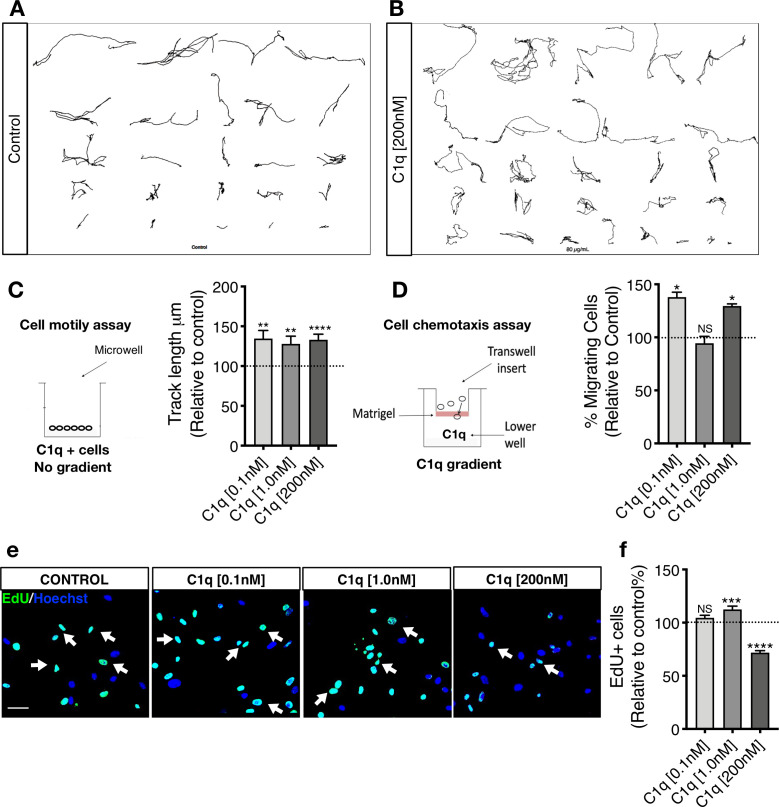
C1q induces NSC motility and chemotaxis in vitro.(A-C) Exposure to C1q in the absence of a gradient increases hNSC motility independent of concentration. Manual tracking of 20 randomly selected cells per biological replicate in live-cell imaging assay reveals that C1q increases hNSC motility as measured by track length, independent of C1q concentration. Representative image of 20 manual tracks from cells in (A) control and (B) C1q [200 nM] condition. (C) Data normalized to untreated control (dashed line). Statistical analysis using one-sample t-test (*p≤0.05, **p≤0.01; N = 3 biological replicates) for comparison with control. ANOVA analysis for comparison between groups, p=0.8682. (D) Exposure to C1q in transwell assay for analysis of chemotaxis reveals that C1q induces hNSC migration in a concentration-dependent manner, with maximal effects at 0.1 nM and 200 nM. Data normalized to untreated control (dashed line). Statistical analysis using one-sample t-test for comparison with control (*p≤0.05, **p≤0.01; n = 4 biological replicates with technical triplicates). ANOVA analysis for comparison between groups, p=0.0005. (E-F) EdU incorporation analysis reveals that C1q modulates hNSC proliferation. Representative image of Edu+ nuclei (green, white arrows) in hNSC exposed to C1q [0.1 nM], [1.0 nM], or [200 nM] for 2DIV. Scale bars 30 µm. (F) Edu+ nuclei quantification. Data shows untreated control (dashed line; mean ± SEM). Statistical analysis using one-sample t-test for comparison with control (NS = not significant p>0.05, ***p≤0.001, ****p≤0.0001; 10 random images/experiment (N), N = 4 biological replicates, averaging 140 ± 60 cells/image. ANOVA analysis for comparison between groups, p≤0.0001.